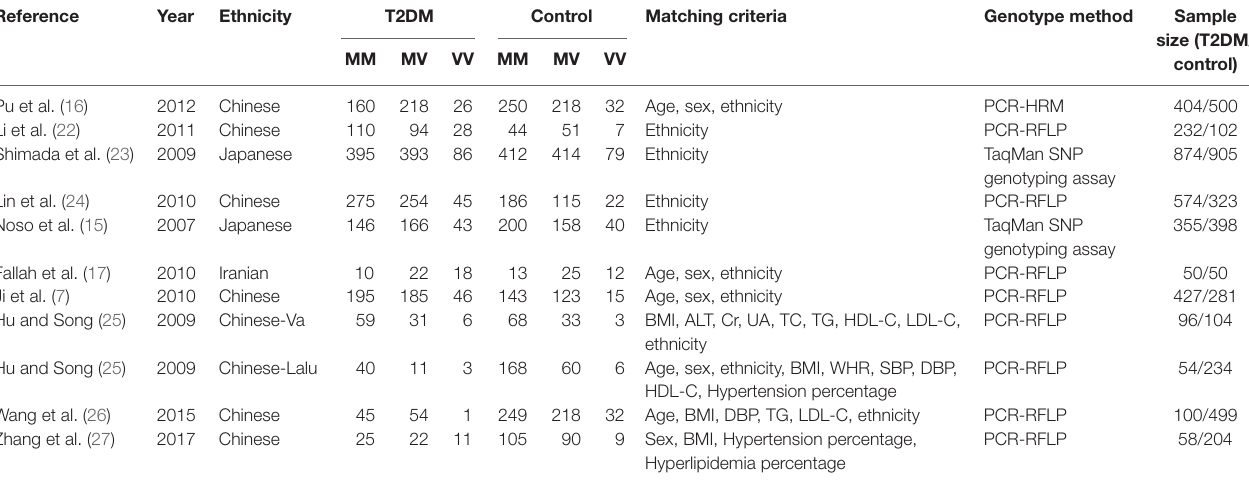
TaBle 1 | Characteristics of the investigated studies of the association between small ubiquitin-like modifier 4 (SUMO4) gene M55V polymorphism and T2DM. reference